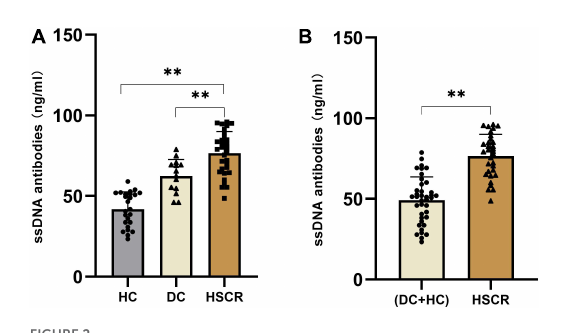
FIGURE2 The ssDNA antibodies increased in HSCR plasma. (A) The level of ssDNA antibodies in HSCR group were compared with the DC and the HC group, respectively. (B) The level of ssDNA antibodies in HSCR group were compared with the DC and HC combined control group. “ ∗∗ P < 0.01” indicates statistical significance, and all P- values were tested by two-sided tests.